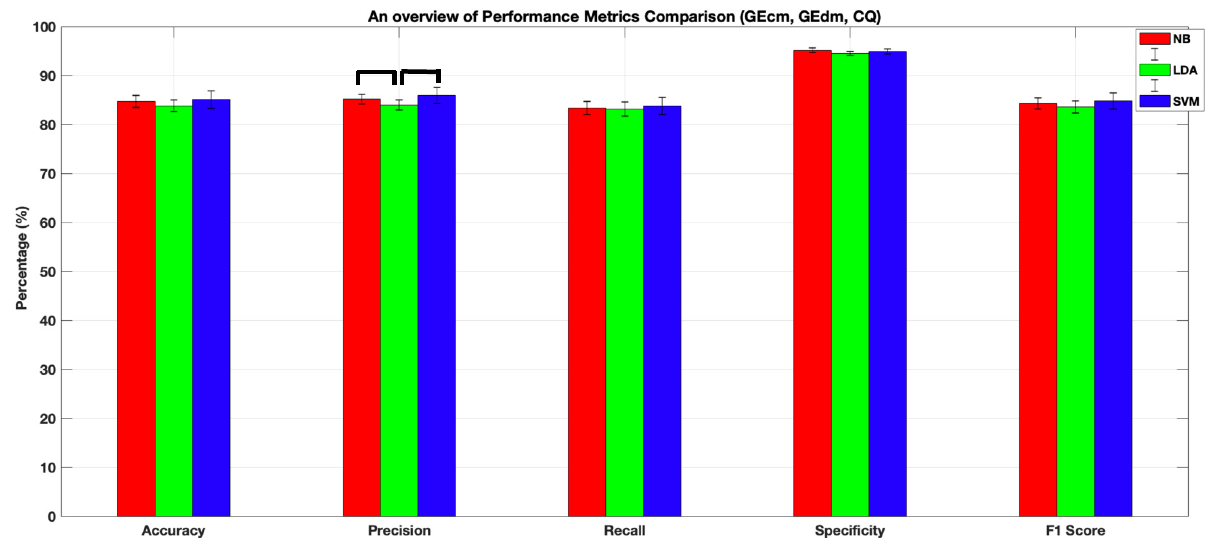
Figure 7. Classification performances of NB, LDA, and SVM algorithms after being trained with a combination of fNIRS and behavioral features (i.e., GE cm , GE dm , and CQ). Horizontal lines depict statistically significant differences between performances of different algorithm pairs. All algorithms achieved accuracy, sensitivity, precision, and recall performances above 83%, while the specificity scores were all above 94%. There was no statistically significant difference among accuracy, recall, specificity, and F1-score performances of the three algorithms. The error bars represent standard error of the mean performance after 10 runs of a 10-fold C.V.